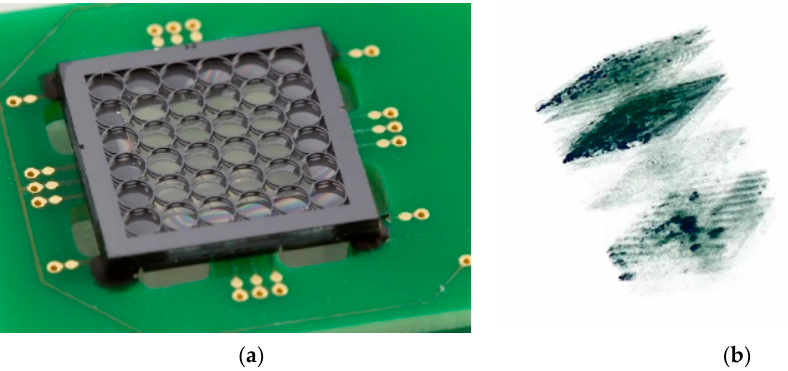
Figure 12. PCB-mounted chip of a Mirau interferometer in ( a ); and 3D swept-source OCT image of onion slices in ( b ).